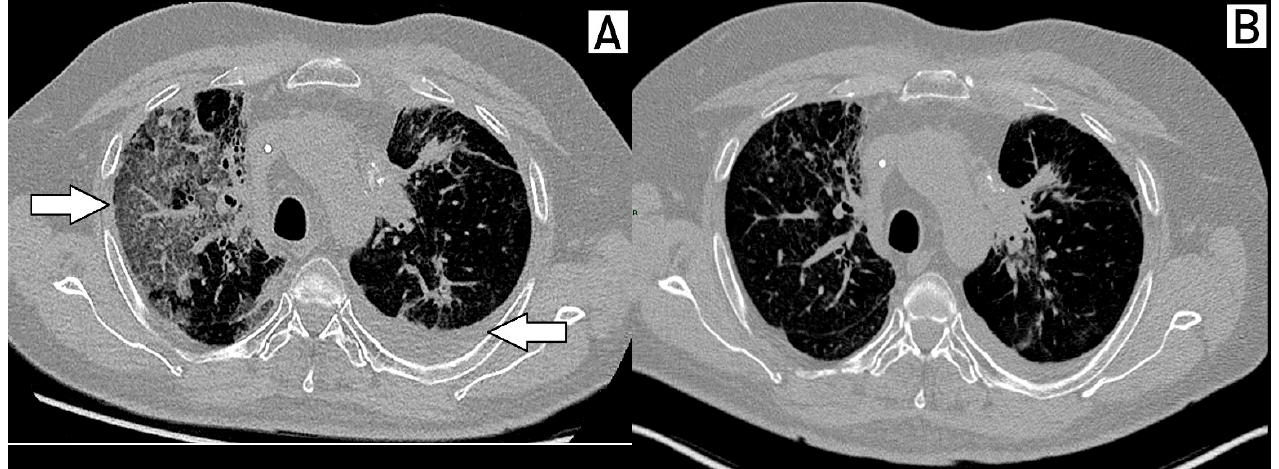
Figure 3. Pneumonitis associated with abemaciclib. Arrows in the figure shows ground-glass opacities, suggesting pneumonitis of the right lung and pleural effusion in the left lung ( A ). Resolution of pneumonitis 3 months after drug discontinuation ( B ).